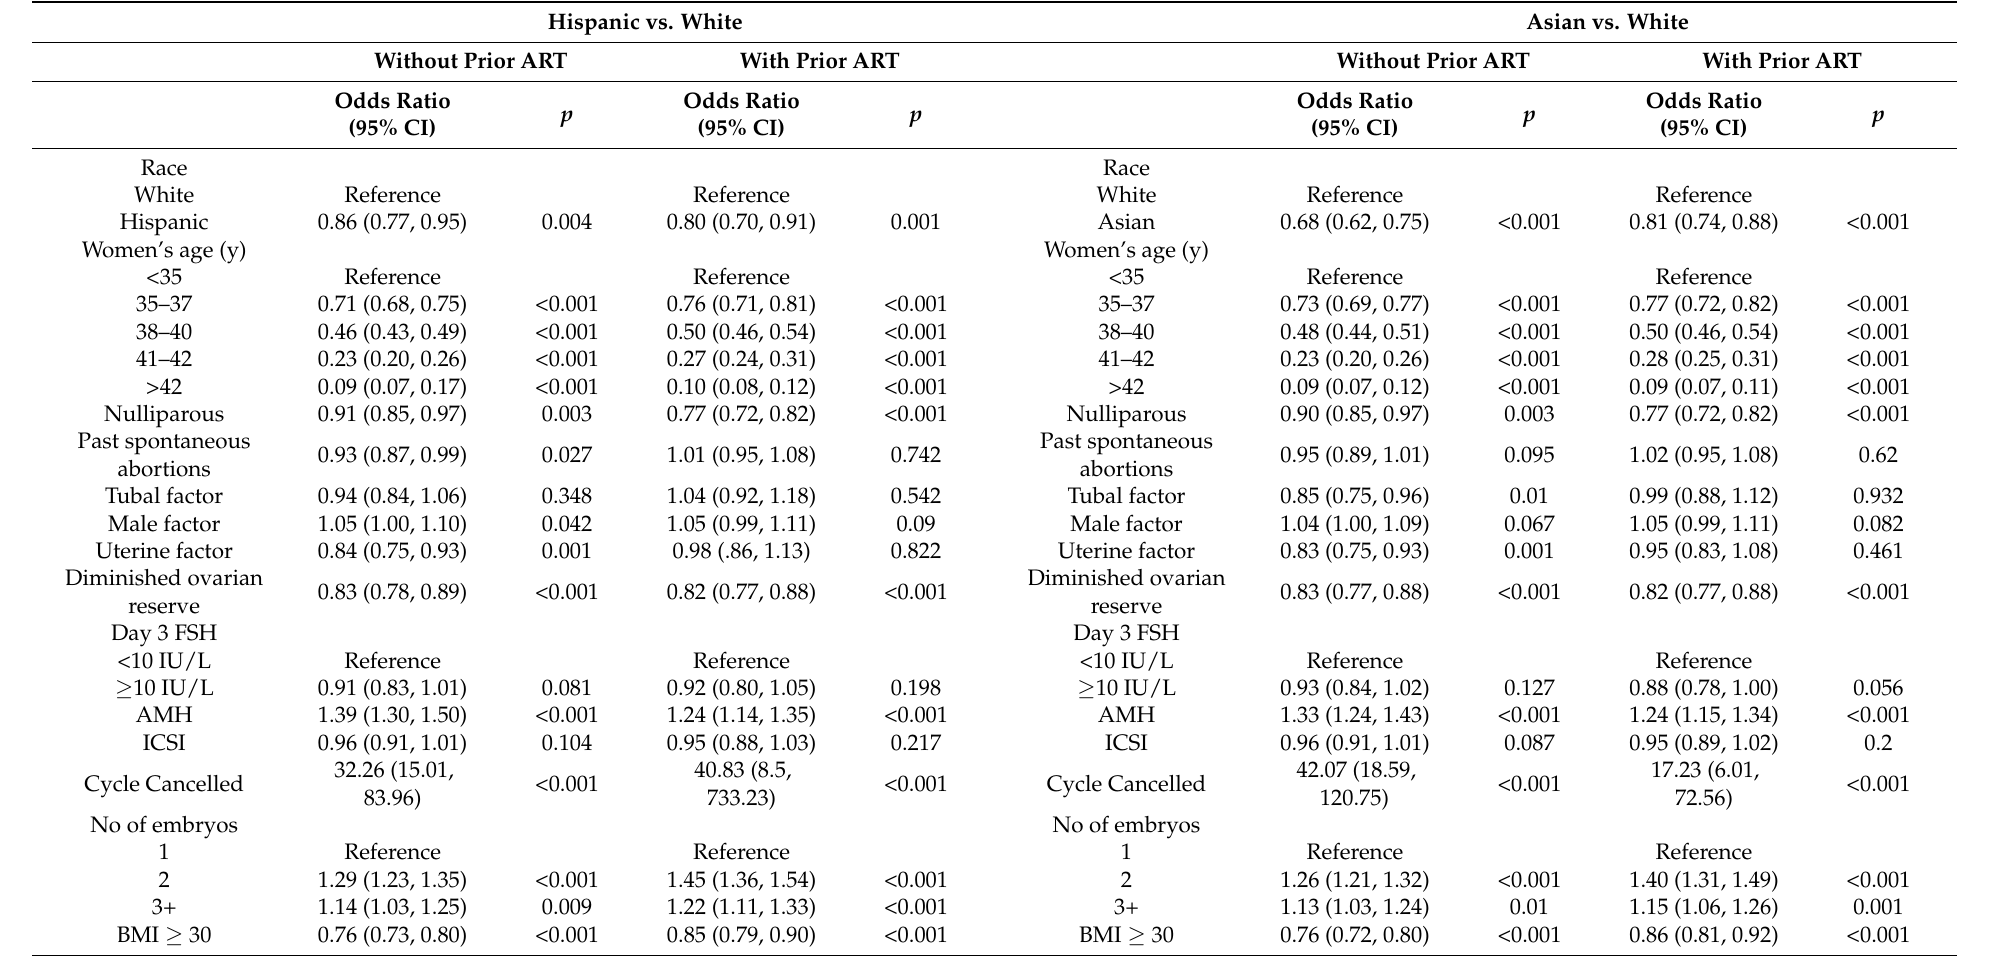
Table 3. Independent predictors of achieving live birth among Hispanic, Asian, and WNH women. Hispanic vs. White Asian vs. White Without Prior ART With Prior ART Without Prior ART With Prior